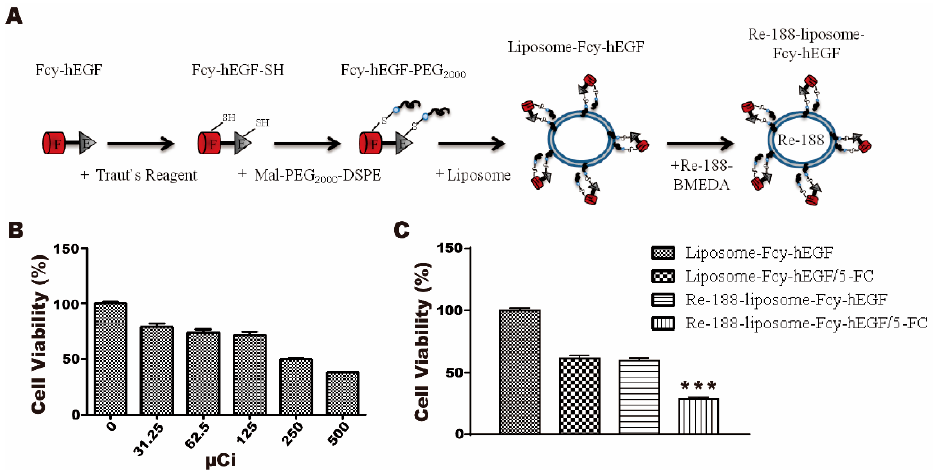
Figure 4. Cytotoxicity of 188 Re-liposome-Fcy-hEGF/5-FC for A431 cells. ( A ) 188 Re was conjugated with BMEDA first, followed by encapsulation into the interior of liposome-Fcy-hEGF. ( B ) Percentage of viable A431 cells treated with different concentration of 188 Re. ( C ) Percentage of viable A431 cells treated with liposome-Fcy-hEGF, liposome-Fcy-hEGF/5-FC, 188 Re-liposome-Fcy-hEGF, and 188 Re-liposome-Fcy-hEGF/5-FC. The specific amount of 188 Re, liposome (phospholipid), Fcy-hEGF, and 5-FC were 100 μ Ci, ~82 nmol, ~3.33 nM, and ~10 μ g in 100 μ L, respectively. The data are means ± SEM of three independent experiments performed in triplicate. *** p < 0.005.